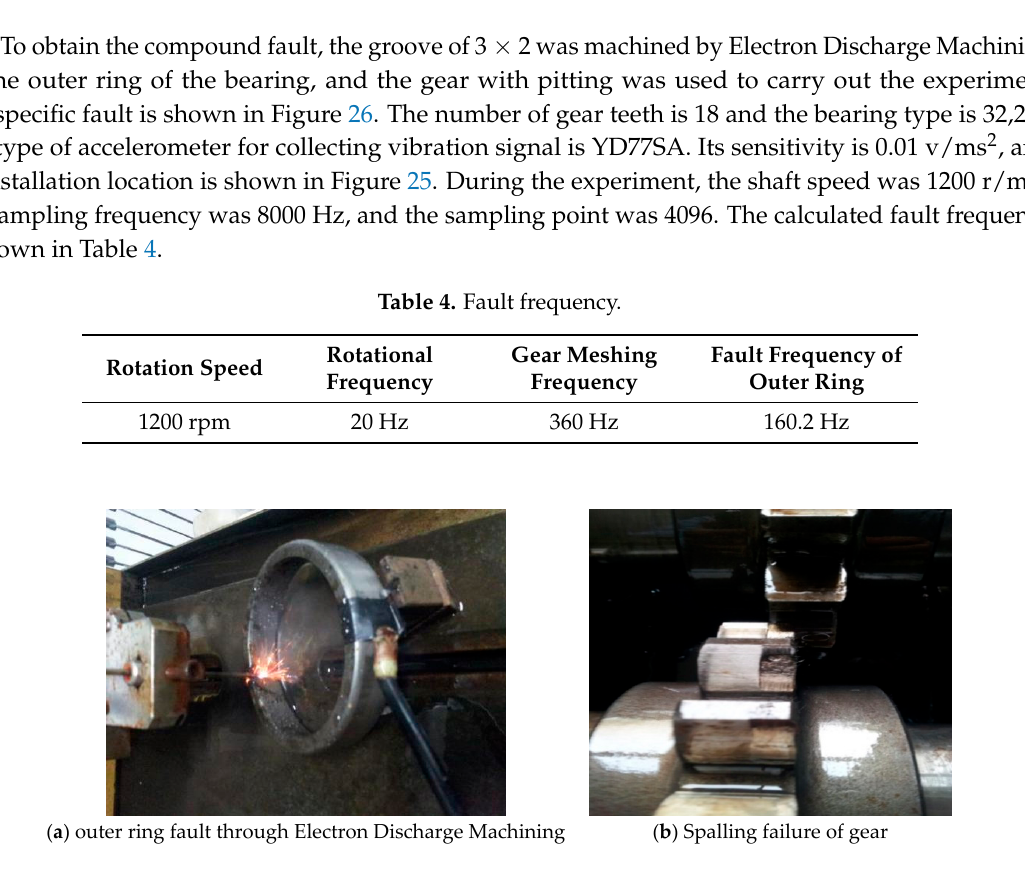
Figure 26. Bearing and gear fault diagram.